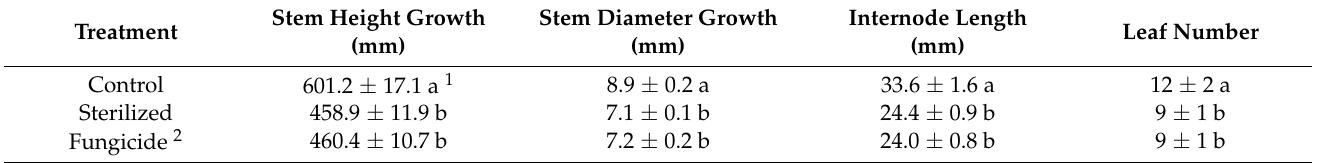
Table 6. The influence of growing Serianthes grandiflora , Serianthes kanehirae , and Serianthes nelsonii plants in soil obtained from Serianthes grandiflora rhizosphere on plant growth traits. Mean ± SE, n = 18.